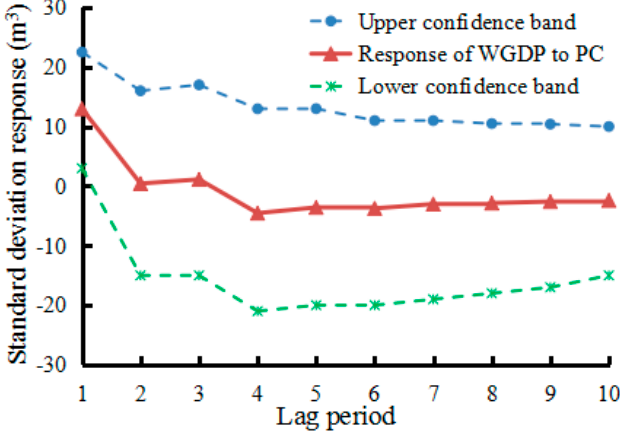
Figure 4. Standard deviation response of WGDP to PC.